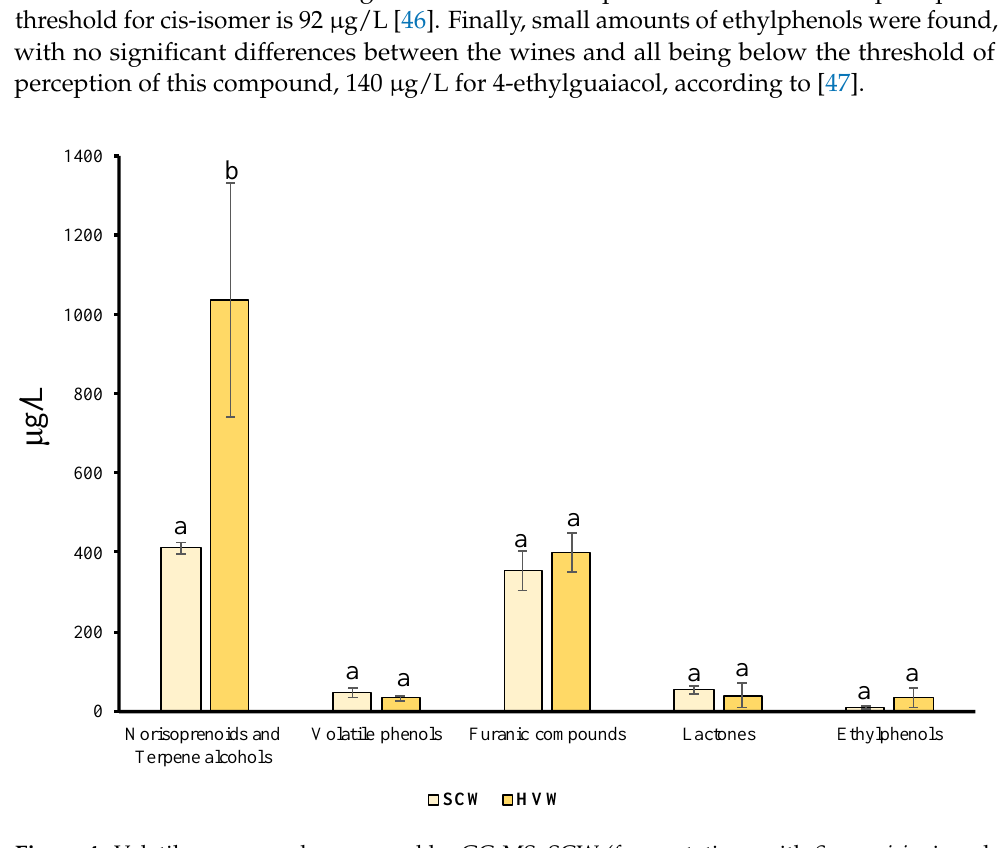
Figure 4. Volatile compounds measured by GC-MS. SCW (fermentations with S. cerevisiae in oak barrels); HVW (fermentations with H. vineae in oak barrels). Mean ± standard deviation of two replicates. Bars with the same letter are not significantly different ( p < 0.05).